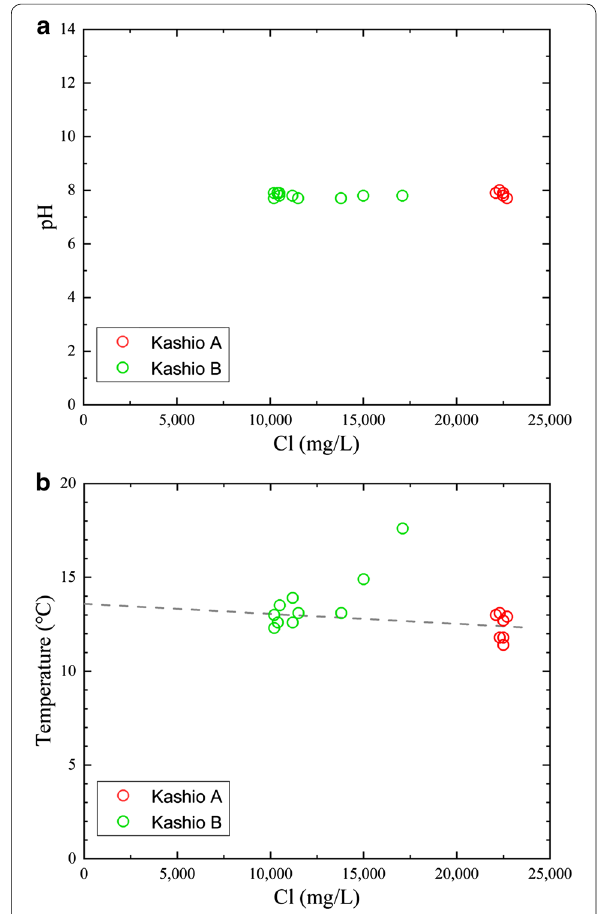
Fig. 2 Relationships between pH and Cl concentration and between water temperature and Cl in water samples from the two wells of the Kashio mineral spring. The pH was constant over the measurement period whereas the Cl concentration varied. Water temperature showed a weak negative correlation with Cl variation, aside from two anomalous values obtained from Kashio B samples (KNK-16-M006 and -M008)